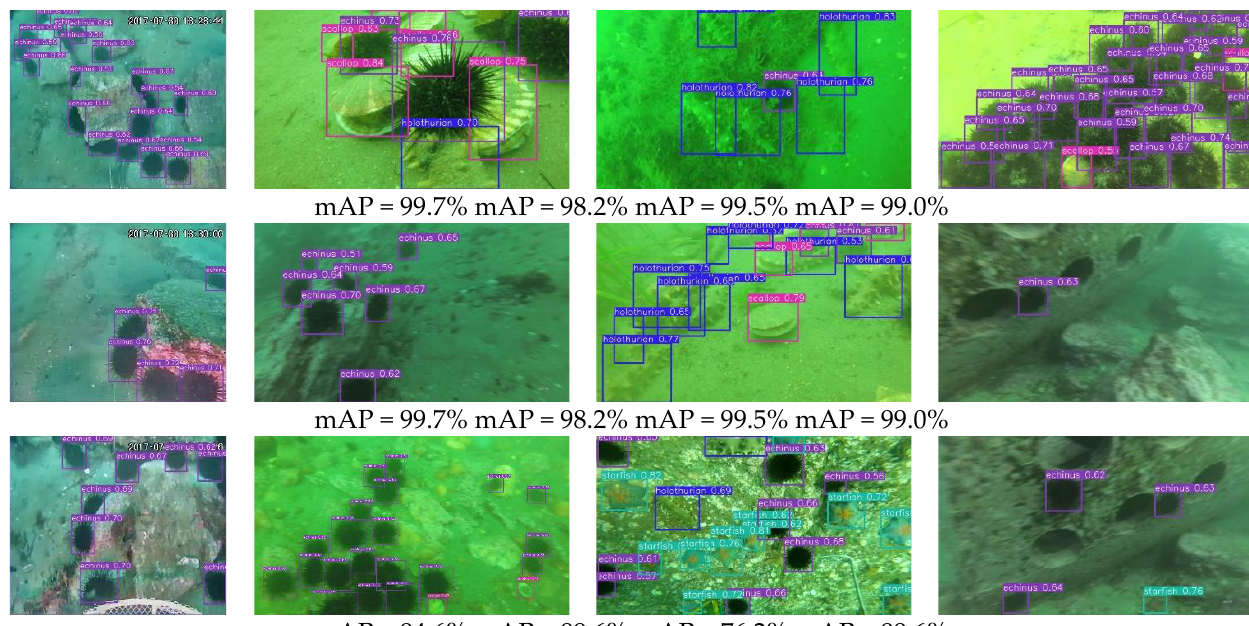
Figure 10. Visualization of the detection results of the algorithms in this